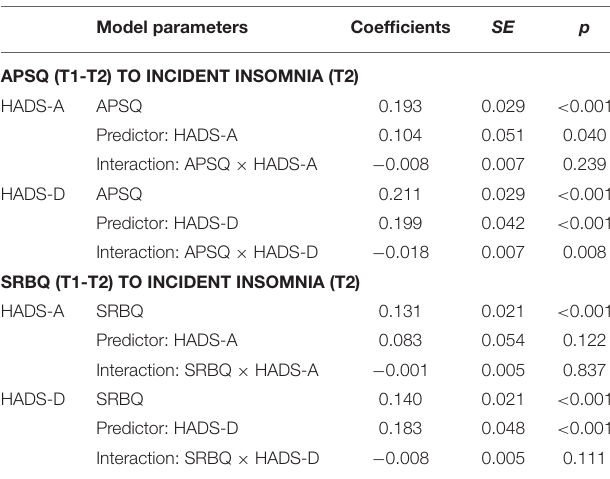
TABLE 6 | Results from the moderation models examining the effects of changes in two cognitive processes (APSQ and SRBQ) from baseline to 6-months follow-up and anxiety and depressive symptoms (HADS-A and HADS-D) at baseline on the incidence of